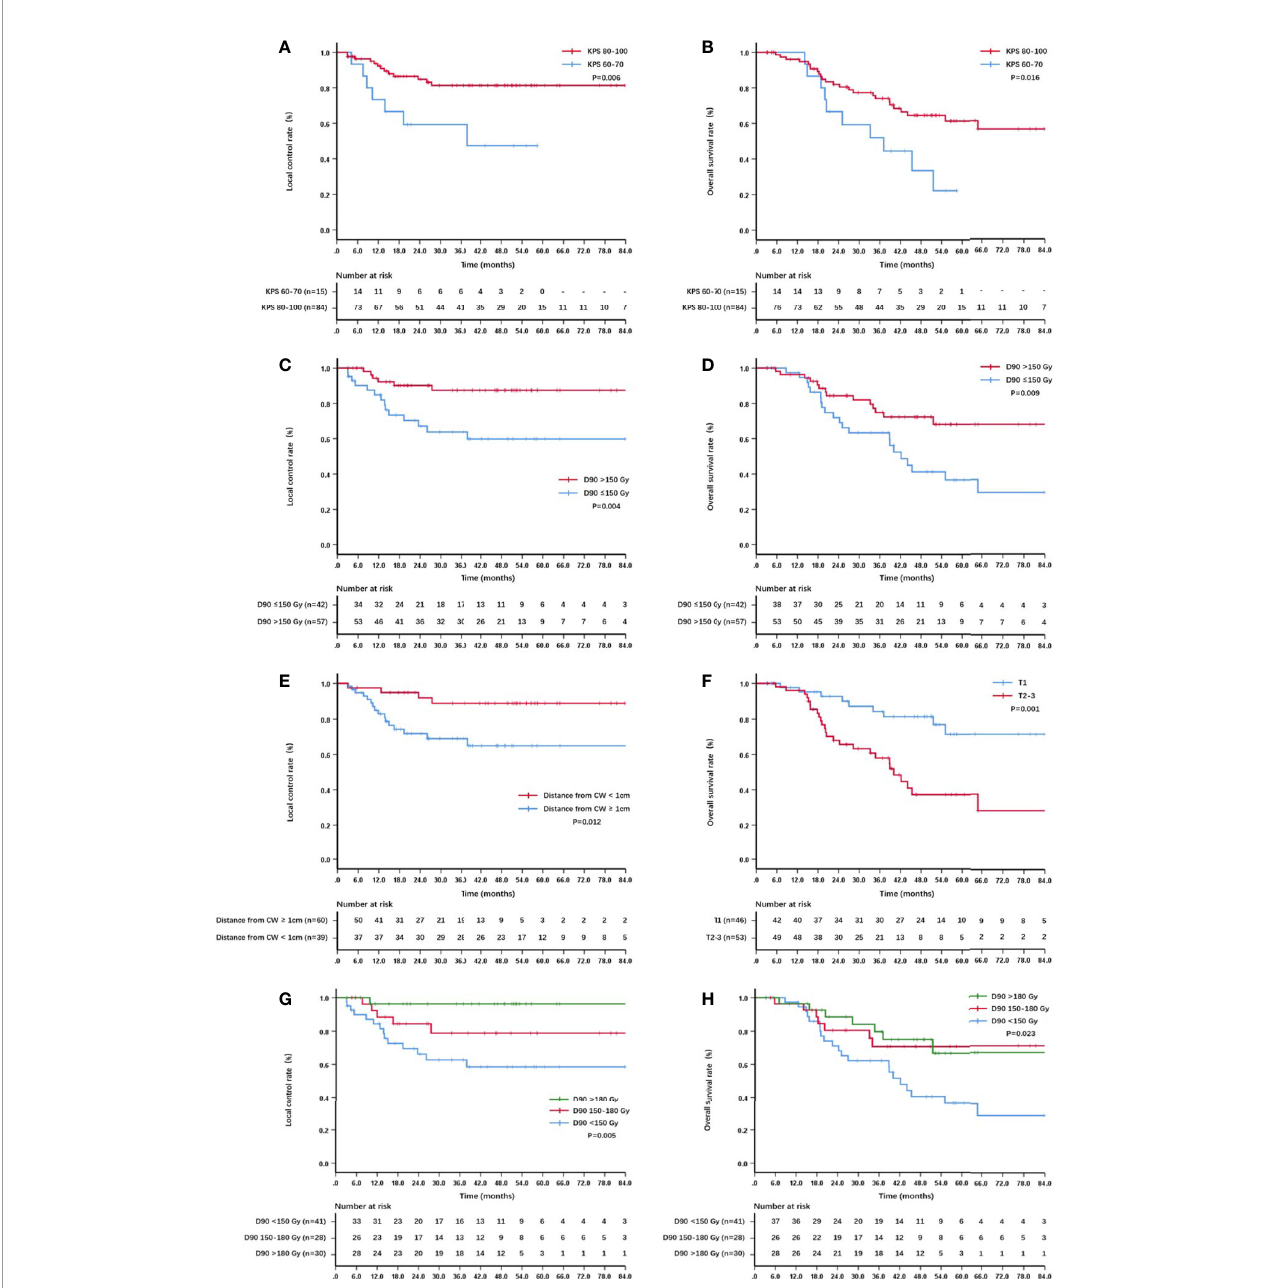
FIGURE 2 | Kaplan – Meier curve about local control and survival: (A) The local control of patients with KPS score 60-70 and 80 – 100; (B) the overall survival of patients with KPS score 60-70 and 80 – 100; (C) the local control of patients with GTV D90 <150 Gy and ≥ 150 Gy; (D) the overall survival of patients with GTV D90 <150 Gy and ≥ 150 Gy; (E) the local control of patients with lesions <1 cm and ≥ 1cm from the chest wall; (F) the overall survival of patients with T1 and T2-3; (G) the local control of patients with D90 <150 Gy, 150-180 Gy,and >180 Gy; (H) the overall survival of patients with D90 <150 Gy, 150-180 Gy and >180